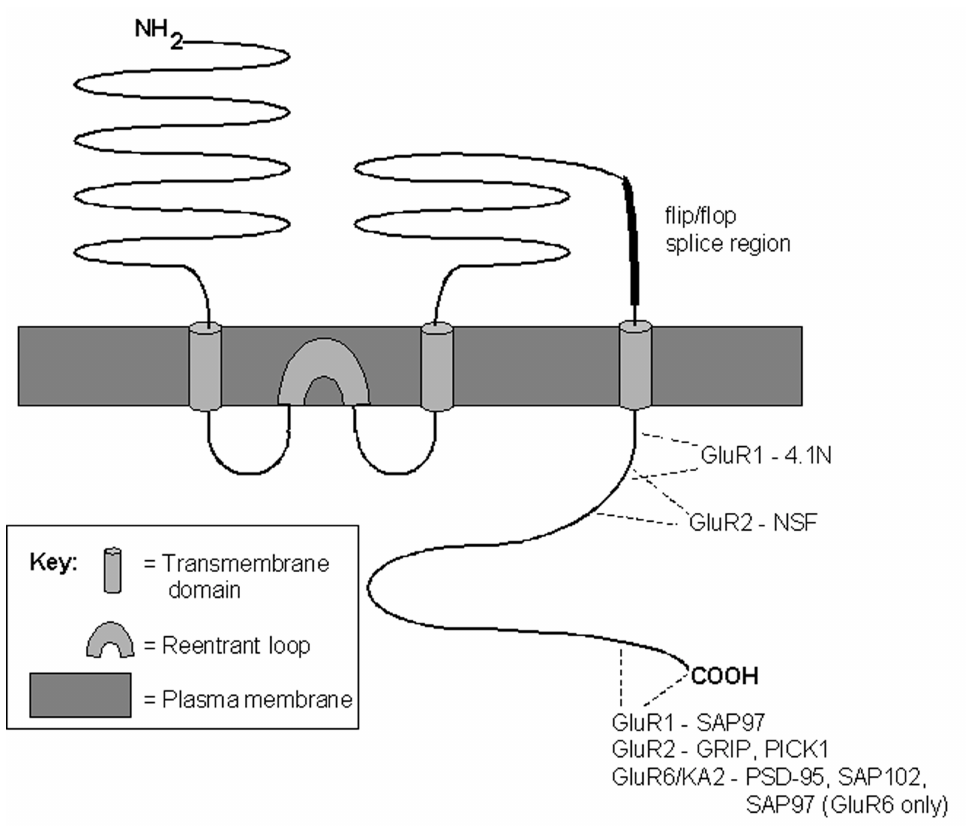
FIGURE 2. Schematic showing the conserved membrane topology of AMPAR and KAR subunits. The sites of protein(cid:150)protein interactions have been indicated where